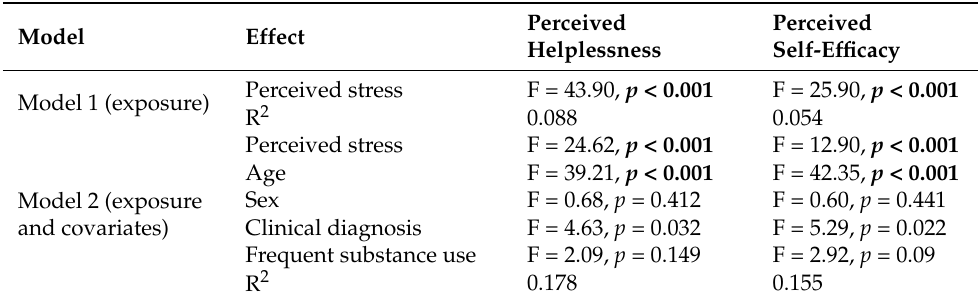
Table 2. Effects of perceived stress on the PQ-16 score after adjustment for general characteristics of the sample.